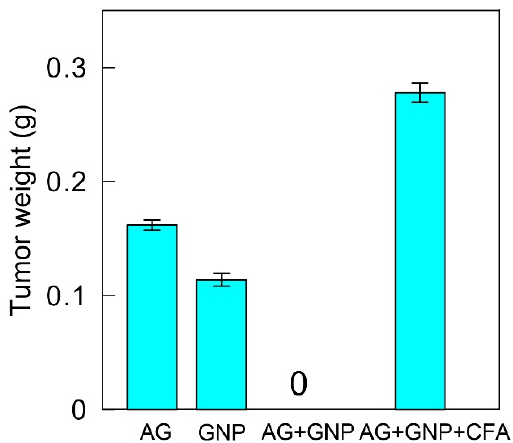
Figure 8. Tumor weight after immunization, subsequent tumor cell transplantation, and euthanasia after 24 days.